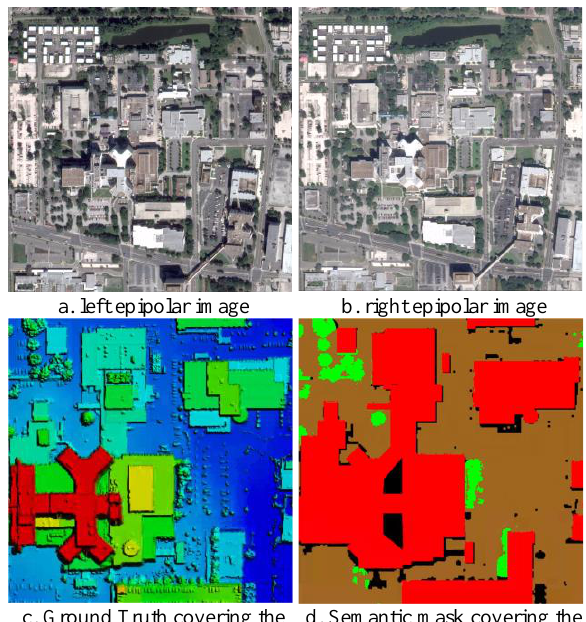
Figure 4. Epipolar images generated from the selected WorldView-3 Stereo Image and corresponding ground